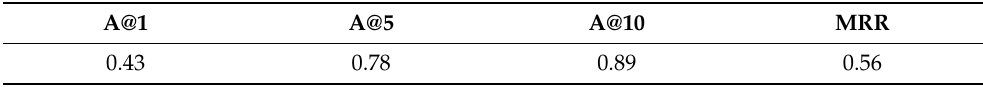
Table 2. The evaluation of CodeHunter search results.